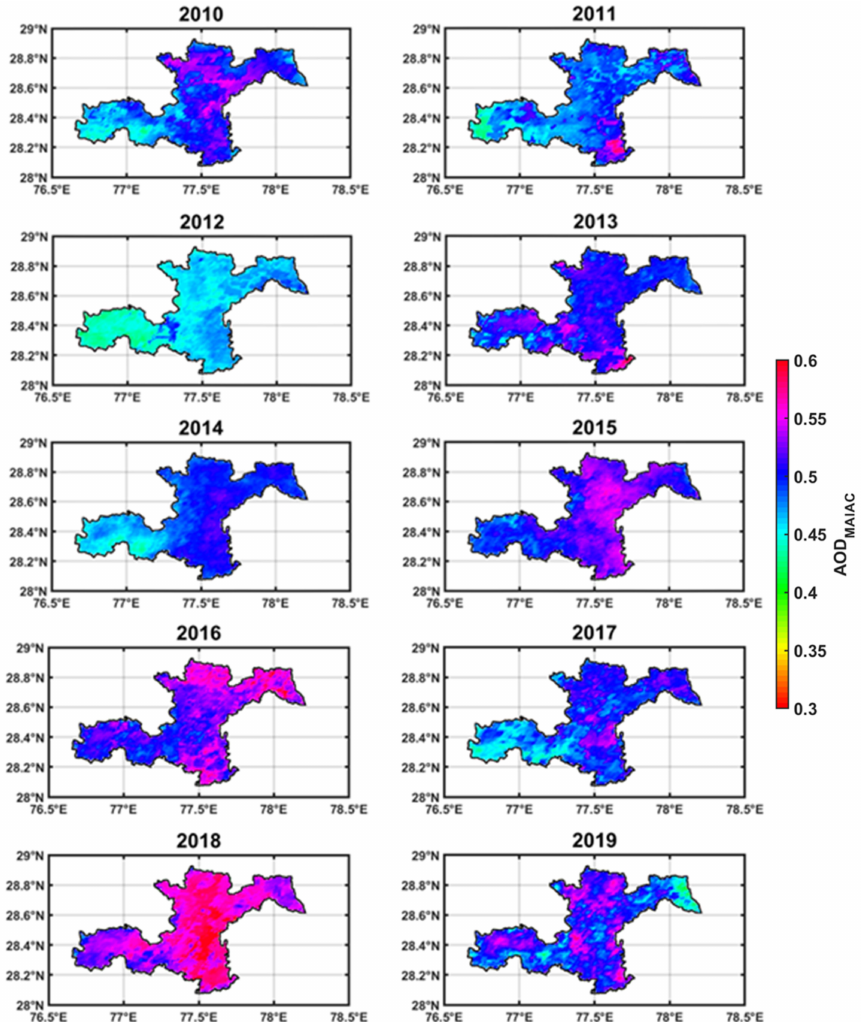
Figure 3. Spatial distribution of annual means of AOD MAIAC retrieved over Gual Pahari and Amity University from 2010 to